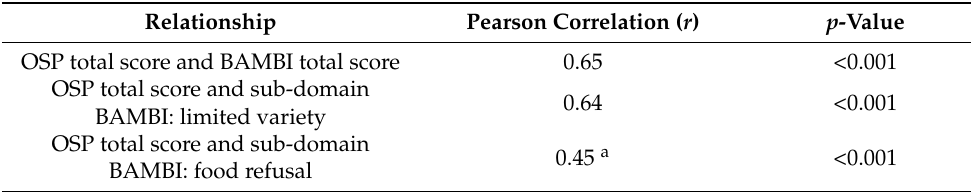
Table 4. The correlation between oral sensory processing and mealtime behaviours among children with ASD ( n = 150).